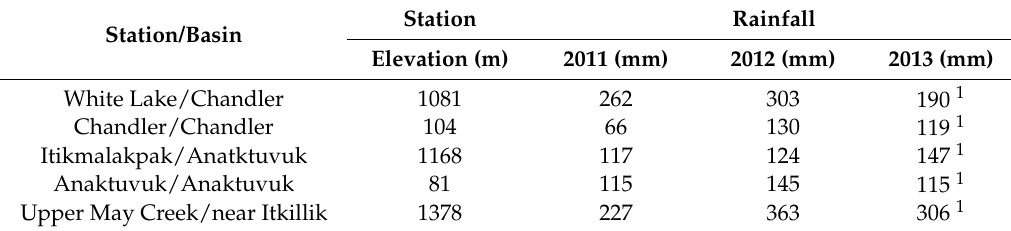
Table 4. Cumulative rainfall from stations in or near the study